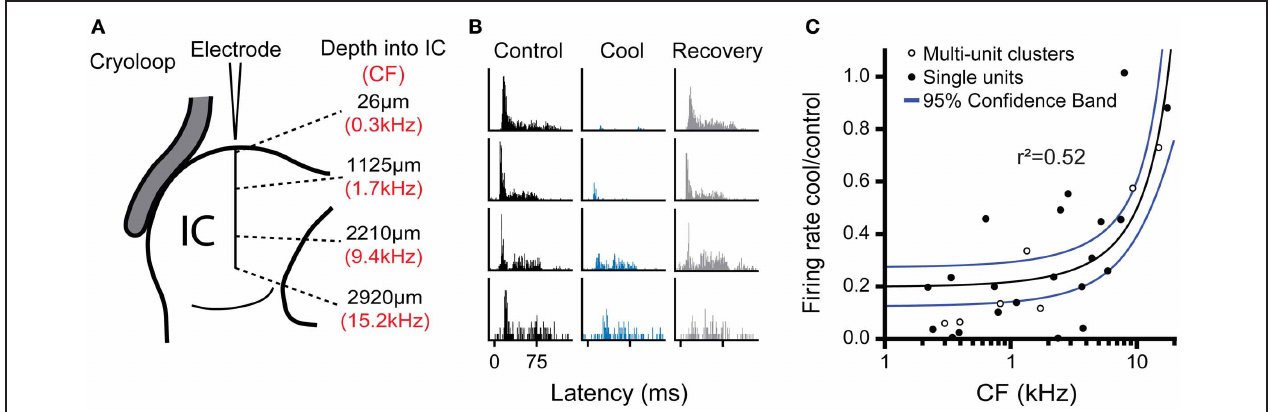
FIGURE 7 | (A) Schematic representation of multi-unit recordings made at approximately 1mm steps in an electrode penetration along the dorso-ventral axis of the IC showing depth from the dorsal surface (black text) and CF of the recorded cluster (red text). (B) PSTHs for activity recorded at the four locations shown in (A) during control, cool, and recovery. Cooling resulted in a notable reduction of spiking in the three most dorsal positions, but had less